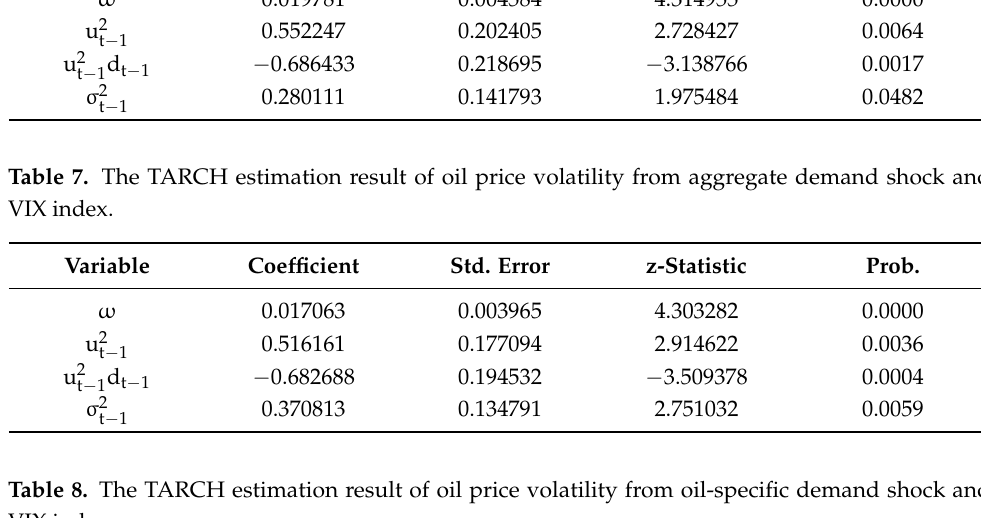
Table 8. The TARCH estimation result of oil price volatility from oil-specific demand shock